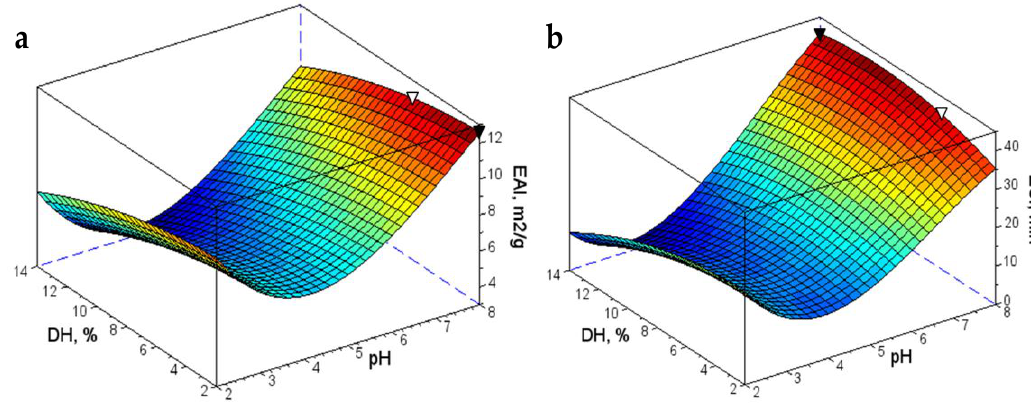
Figure 3. Surface plots of ( a ) EAI and ( b ) ESI for the soy hydrolysates.